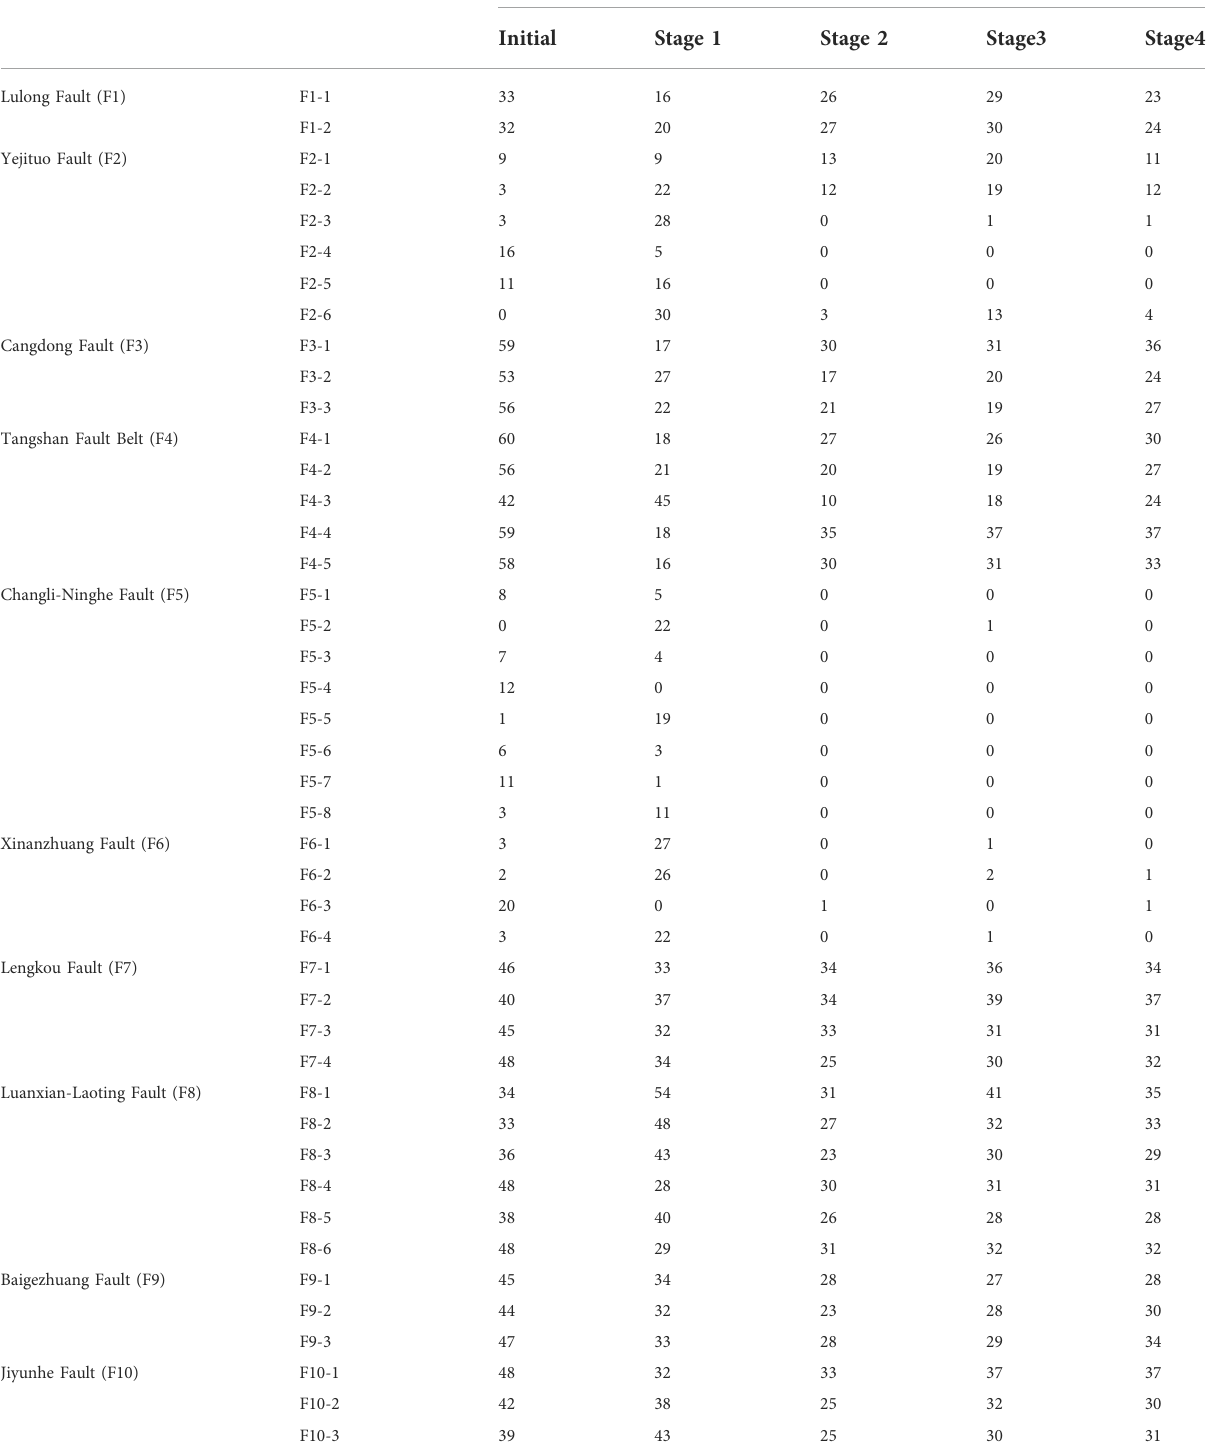
Initial Stage 1 Stage 2 Stage3 Stage4